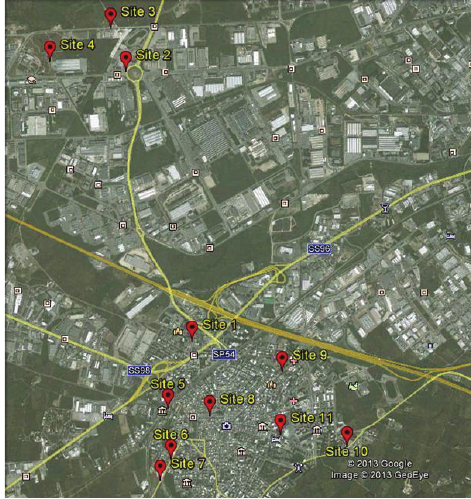
Figure 1: Map of Modugno: sampling sites.